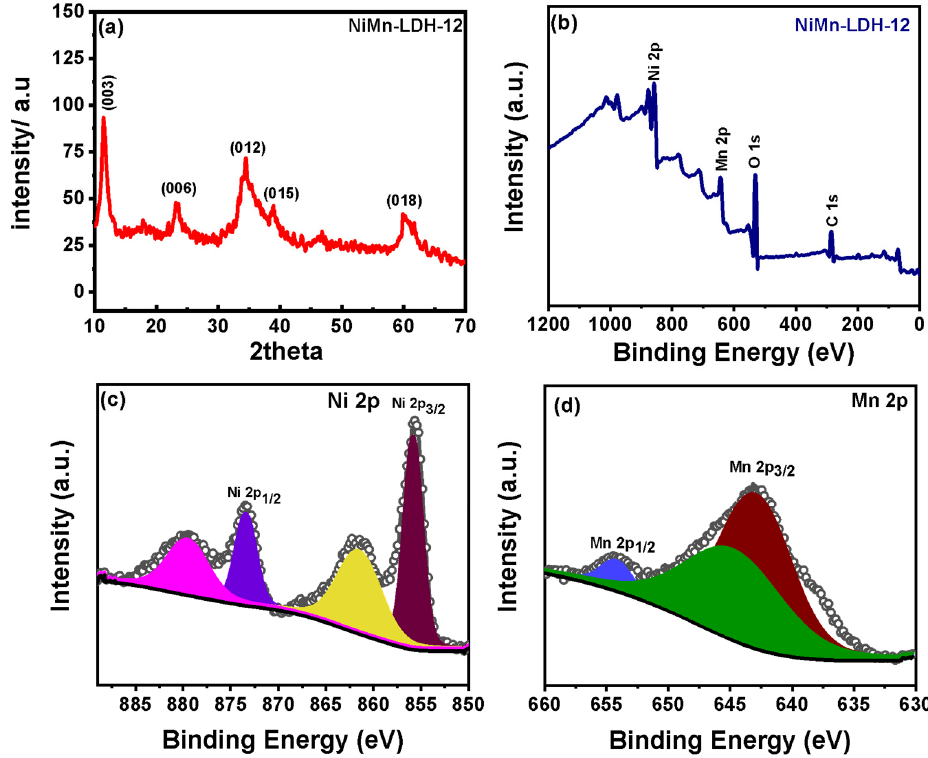
Figure 3. ( a ) X-ray diffraction pattern of the representative NiMn-LDH-12 hollow sphere; ( b ) corre- sponding XPS survey spectrum; ( c ) the high-resolution Ni 2p and; ( d ) Mn 2p binding energies